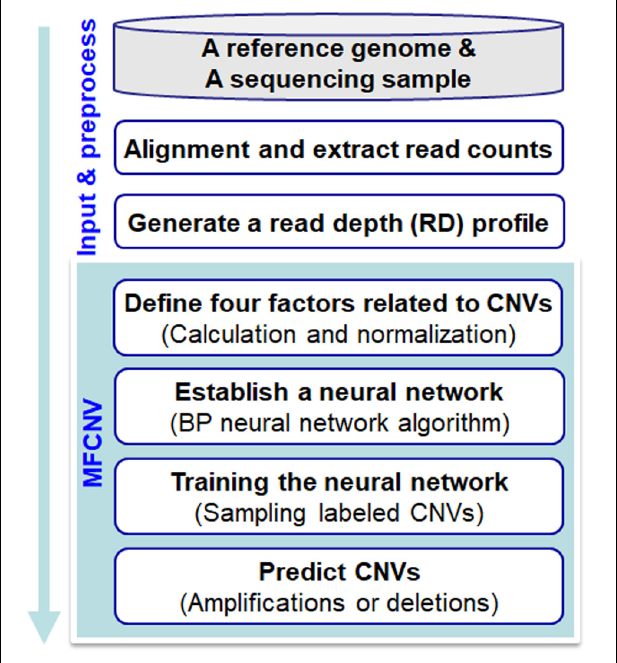
TABLE 1 | The characteristics of the existing